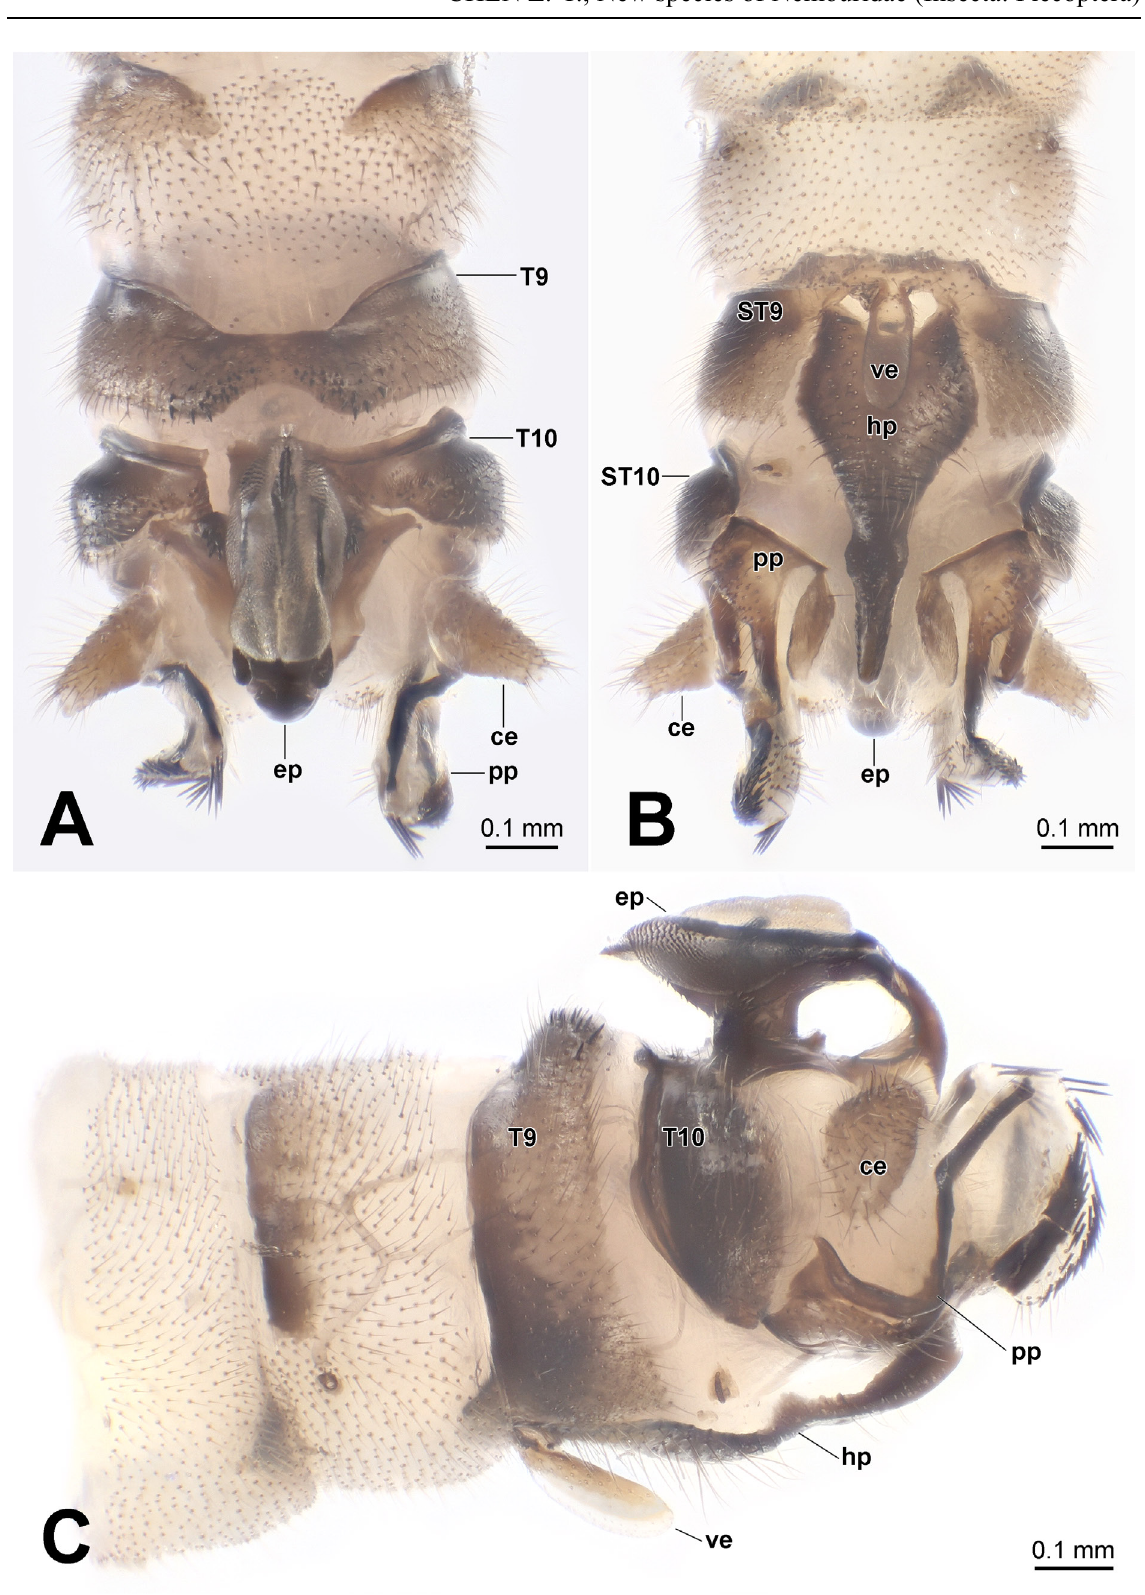
Fig. 9. Amphinemura jiaoheensis sp. nov. A . Male terminalia after NaOH treatment, dorsal view. B . Male terminalia after NaOH treatment, ventral view. C . Male terminalia after NaOH treatment, lateral